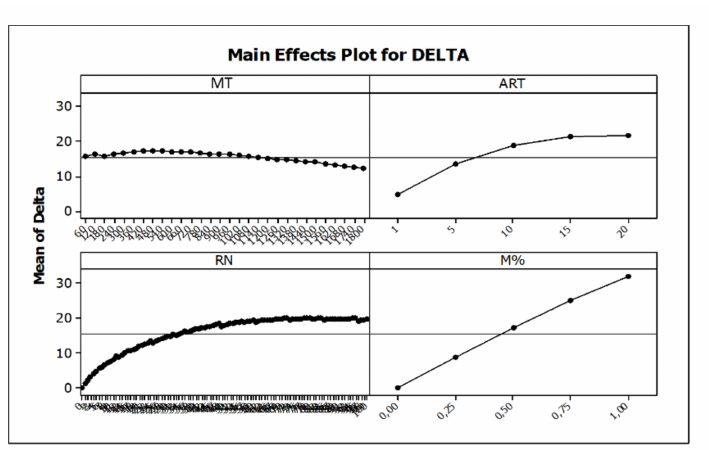
Figure 10. Main effect plot of gap percentage of the cycle time between the two configurations (DELTA) versus mounting time (MT), average reconfiguration time (ART), number of reconfigurations (RN), average masked time percentage